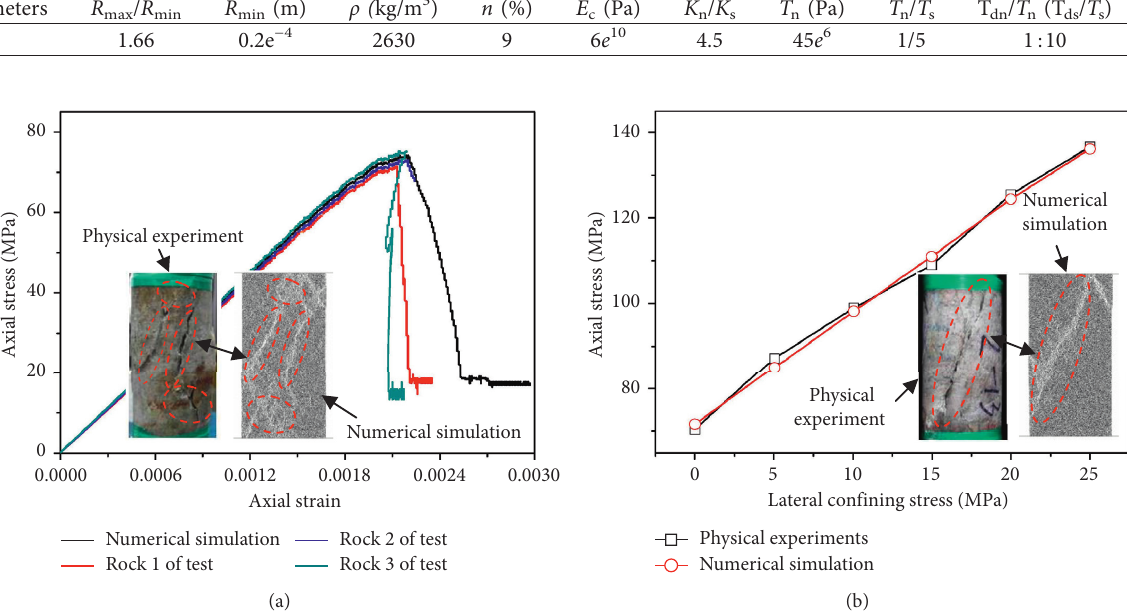
Figure 6: The compared results of physical experiments and numerical simulation: (a) uniaxial experiments and (b) biaxial experiments.